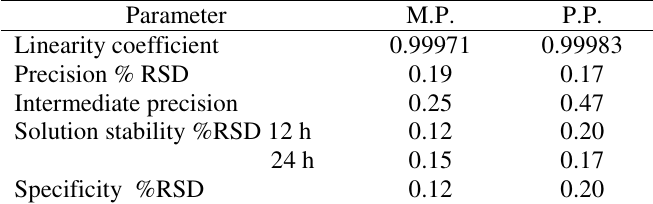
Table 2 . Calibration